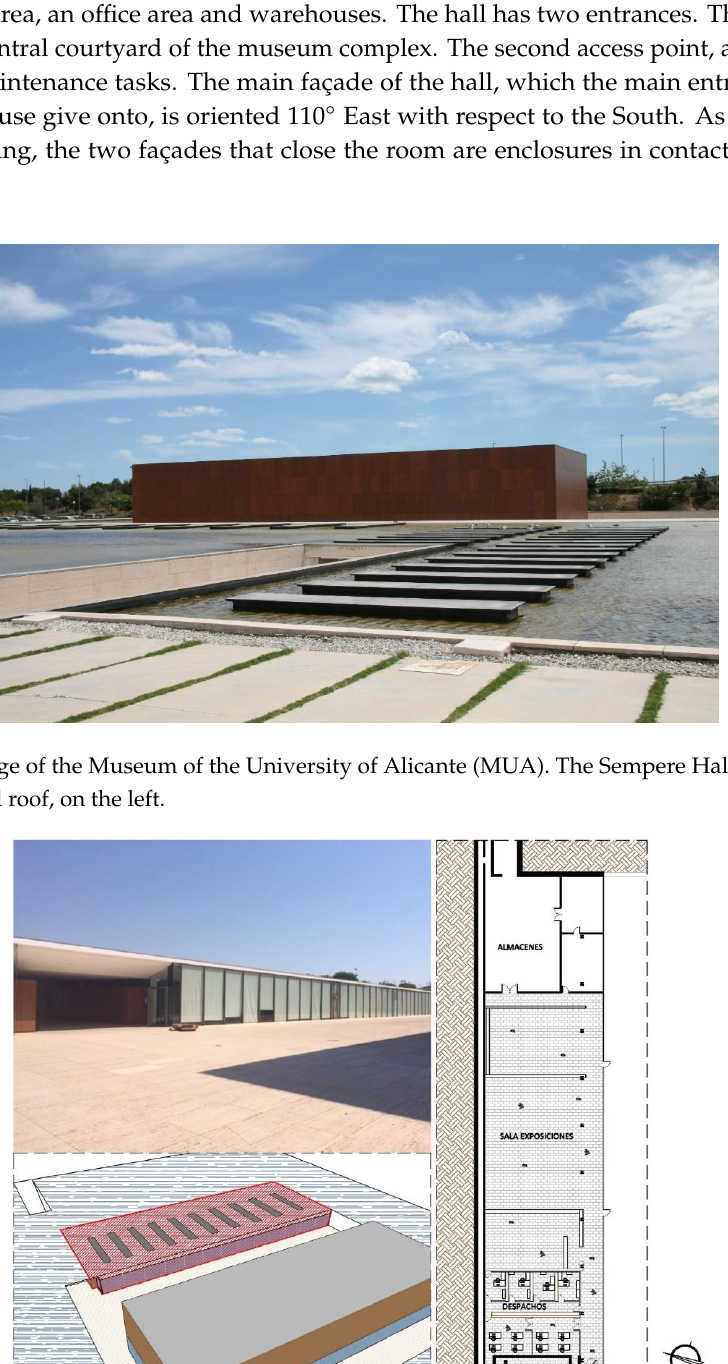
Figure 4. Image of the façade of the Sempere Hall from the inner courtyard. The roof of the Sempere Hall is in red. On the right, the floor plan.